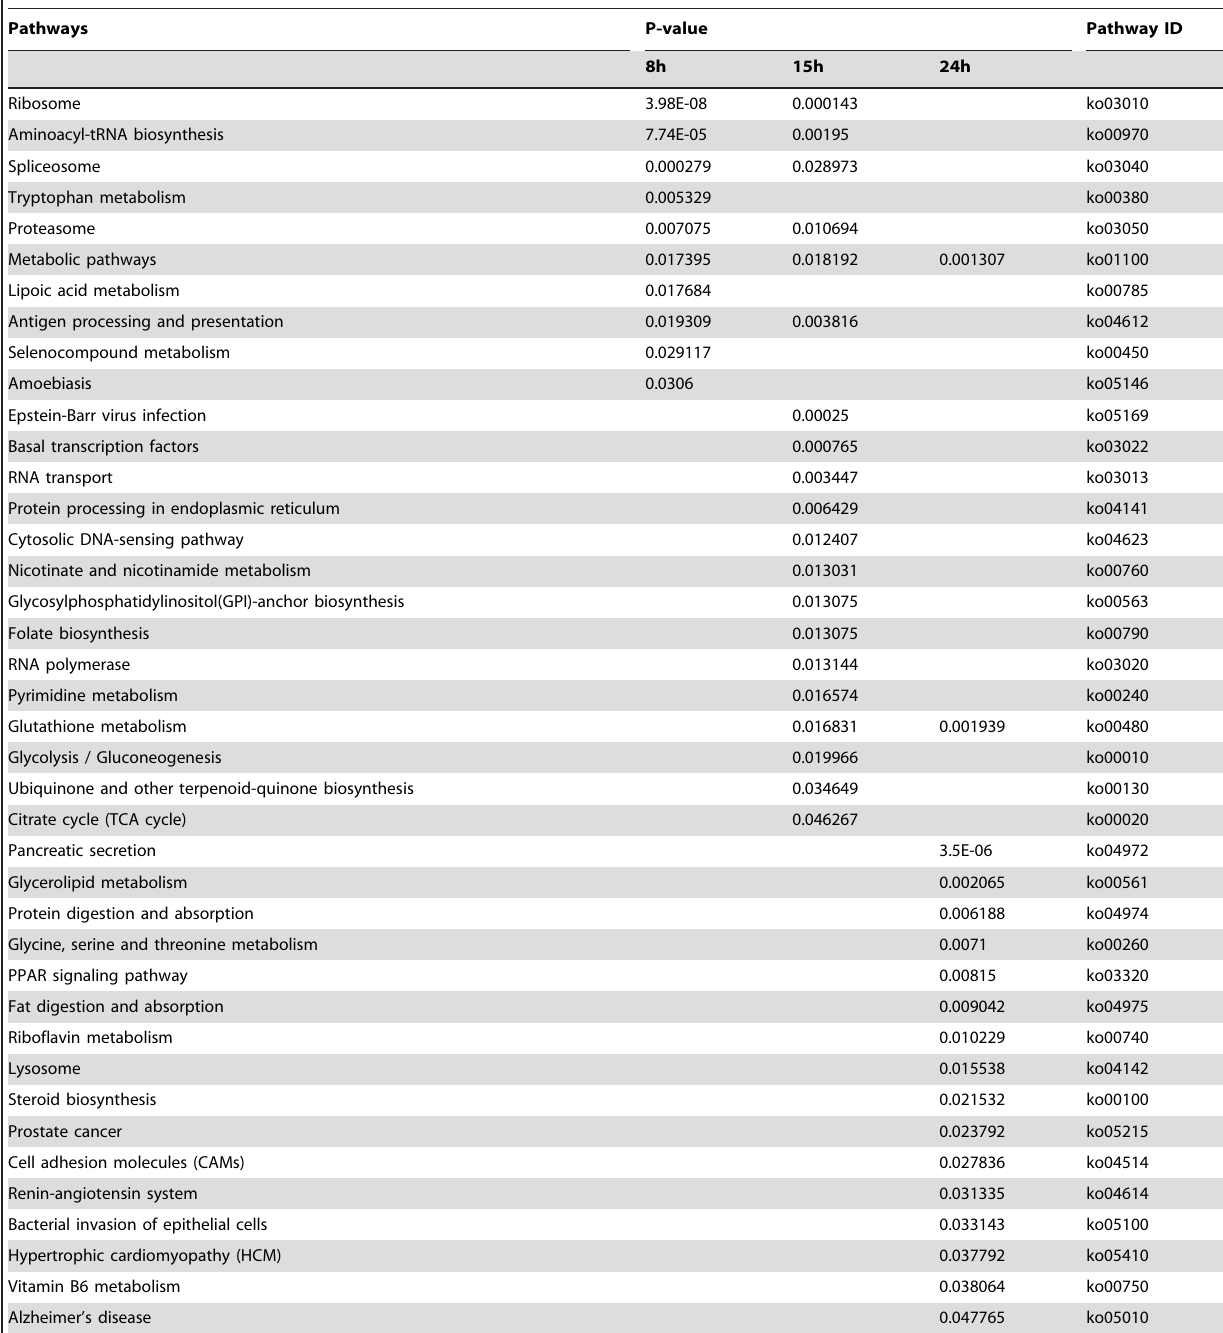
Table 2. KEGG Pathways identified at 8, 15 and 24